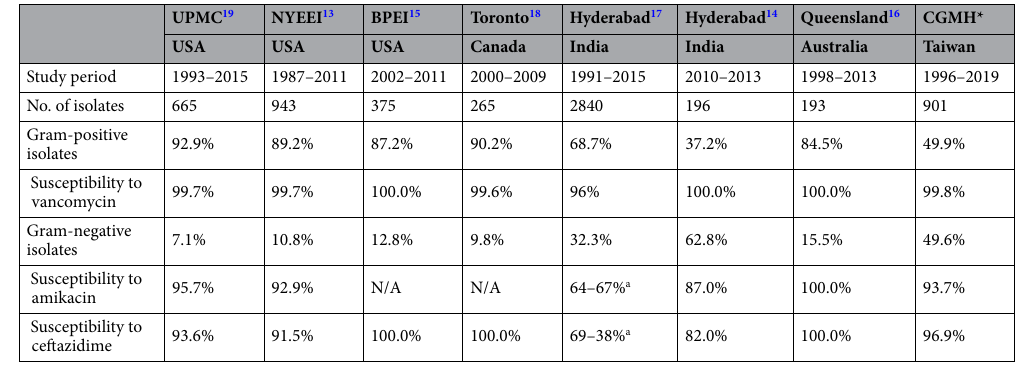
Table 5. Review and comparison of bacterial endophthalmitis isolates. BPEI Bascom Palmer Eye Institute, CGMH Chang Gung Memorial Hospital, N/A not available, NYEEI New York Eye and Ear Infirmary, UPMC University of Pittsburgh Medical Center. *Including 4 Gram-variable isolates. a 2005 →